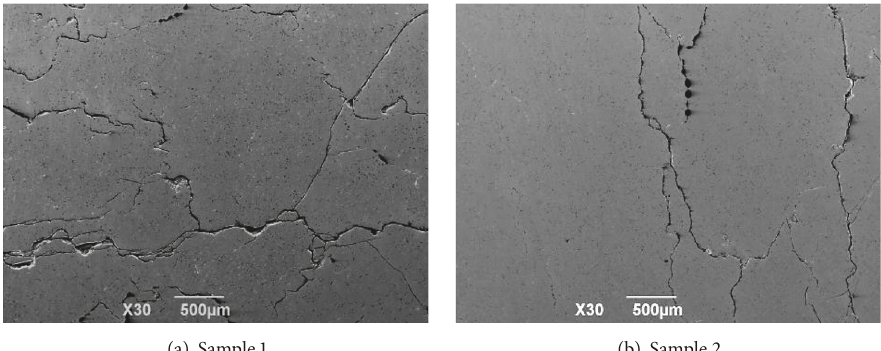
Figure 3: Surface structure cut from solidified melt.